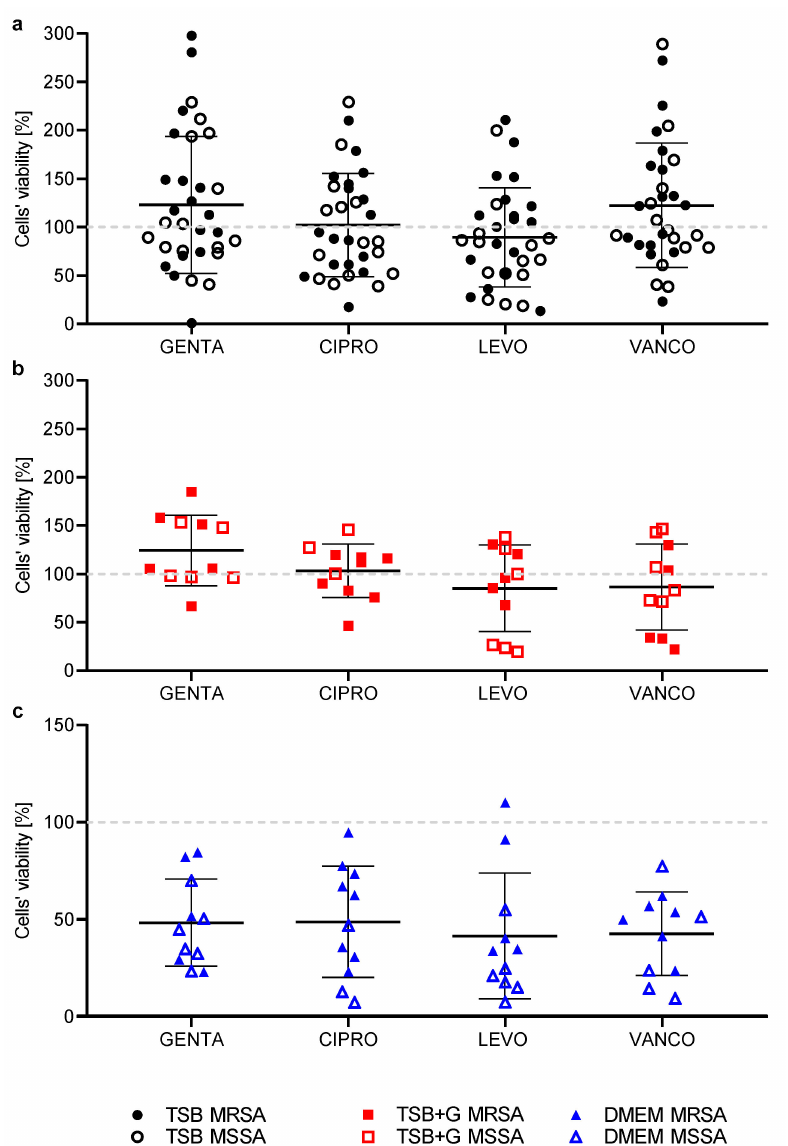
Figure 5. Viability of methicillin-susceptible MSSA and methicillin-resistant MRSA Staphylococcus aureus cells in biofilm formed on the hydroxyapatite discs in three different culture media: ( a ) tryptic soy broth TSB, ( b ) tryptic soy broth with 1% glucose TSB + G, and ( c ) Dulbecco’s Modified Eagle Medium DMEM, after exposure to gentamycin GENTA, ciprofloxacin CIPRO, levofloxacin LEVO, and vancomycin VANCO. Average and standard deviations were calculated for three replications obtained in one experiment, repeated two more times for all